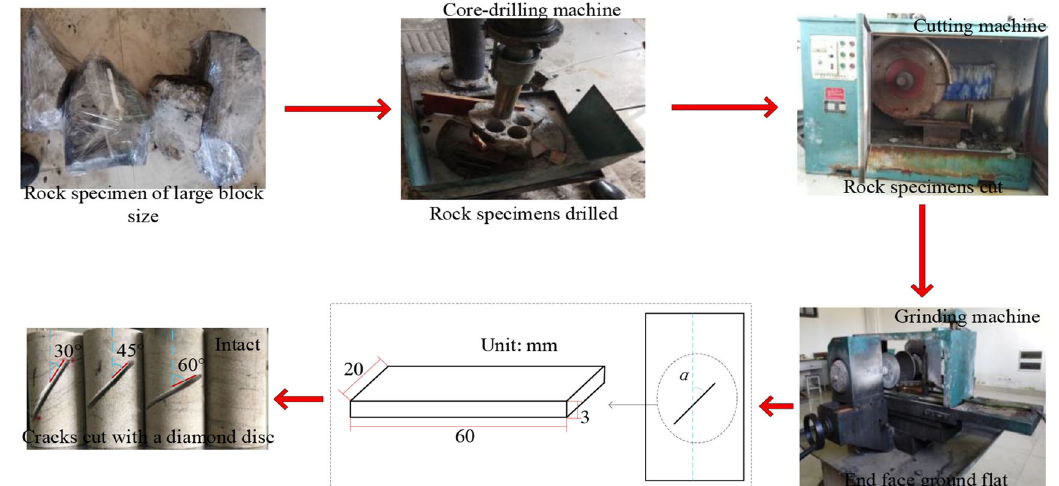
Fig. 1 Flowchart of preparation of specimens from large rock samples